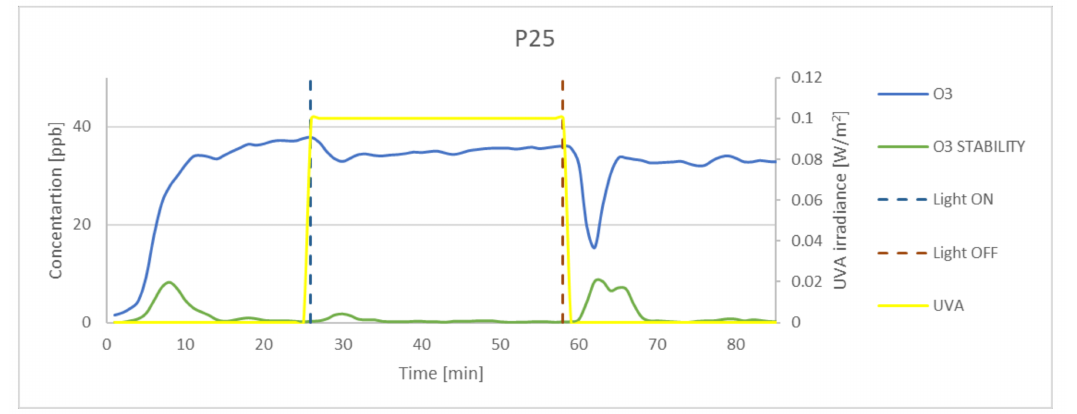
Figure 9. The oxidation of O 3 in the photocatalytic reaction with concentrations measured for P25. Data on UVA irradiation are shown in the supplementary chart. Dashed lines indicate the time of light on and off.